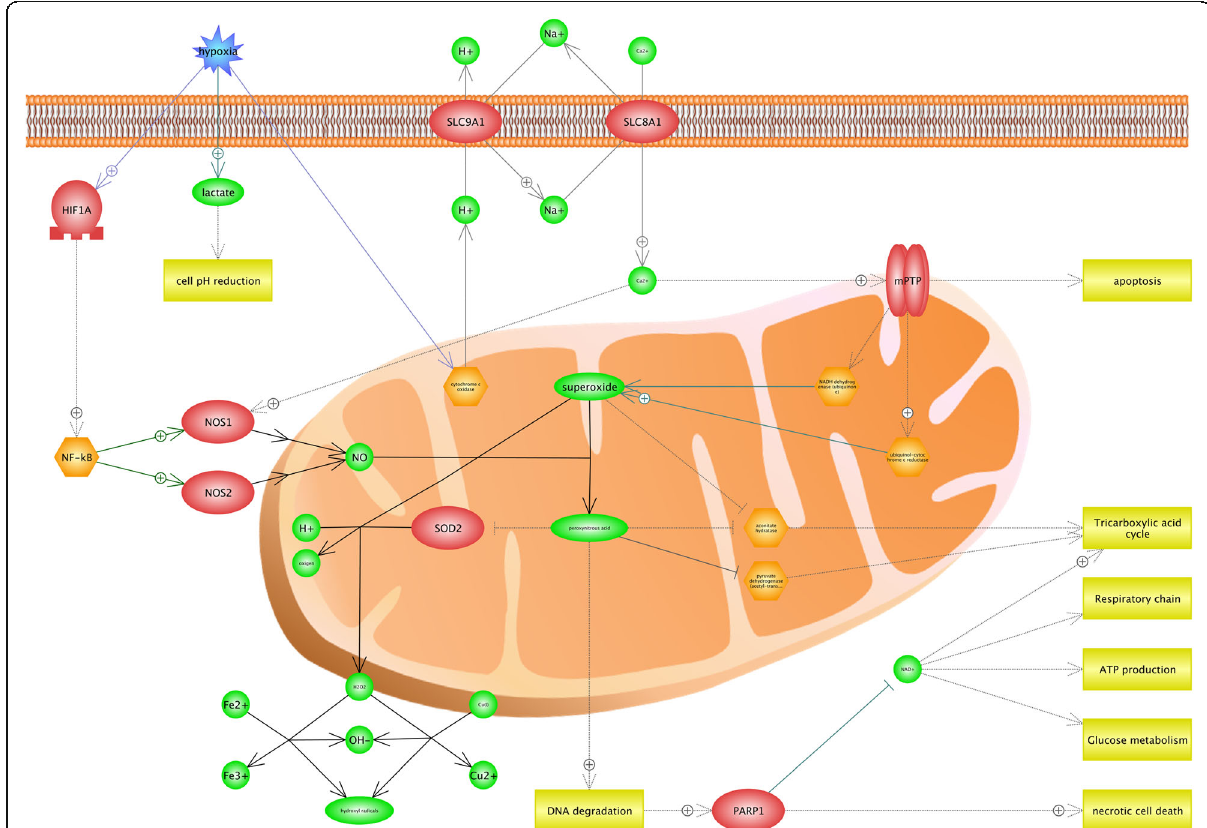
Fig. 2 The effect of hypoxia on mitochondrial damage. Hypoxia reduces the level of pH in cells, which will result in the increased lactate. The process of transferring that exists in plasma membrane depends on the cellular pH. Thus, the level of Ca 2+ increases in the cytoplasm. The high concentration of Ca 2+ contributes in two processes of the cell. First, it enhances MPTP complex (mitochondrial permeability transition pore) and leads to the ATP depletion, mitochondria damage, and apoptosis. Additionally, MPTP has a regulatory role in superoxide and peroxynitrous acid productions and DNA degradation. Second, Ca 2+ contributes in the peroxynitrous acid production of superoxide, indirectly. This figure shows